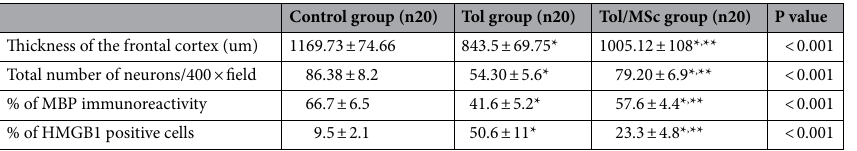
Table 3. Statistical comparison of the morphometric analysis for H&E histological examination (thickness of the frontal cortex, total numbers of neurons) and the area percentage (area %) of MPB immunoreaction and HMGB1 positive cells among different studied. One-way ANOVA, and Tukey HSD Post-hoc Test, P > 0.05: no significant differences, P < 0.05: significant differences. *Significant vs control group. **Significant vs Tol